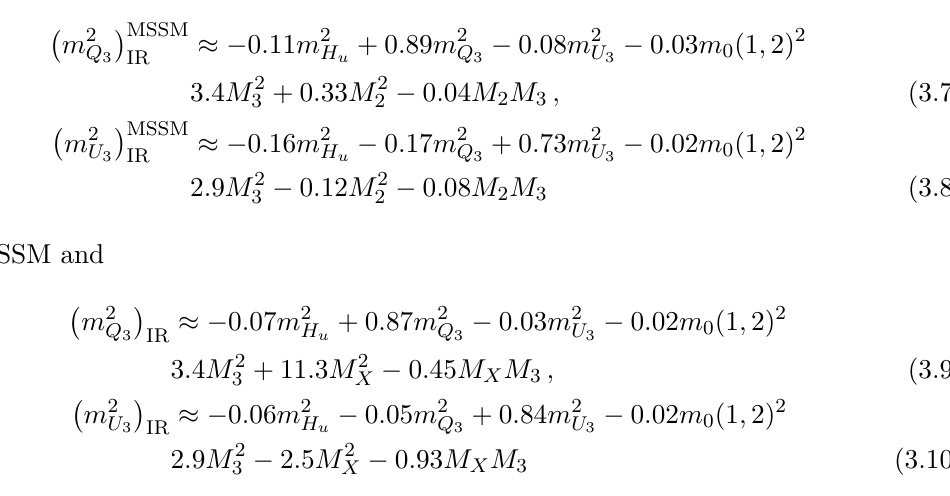
Figure 2 . Contours of the (cid:12)ne-tuning measure (cid:1) in the plane of IR values of the soft gluino mass M 3 and the mass of degenerate stops m stop . The solid red contours corresponds to g X = 2 : 5, (cid:15) 2 = 0 : 95 and tan (cid:12) = 10. Values of (cid:1) in MSSM are depicted by the blue dashed contours for comparison. In the left (right) panel the sfermions of the (cid:12)rst two generations are set to 3 (10) TeV. The remaining parameters are set to values which do not lead to substantial corrections to the EWSB scale: (cid:22) = M 1 = M 2 = 200 GeV and the soft SU(2) X gaugino mass M X = 0. in IR as a function of the UV soft